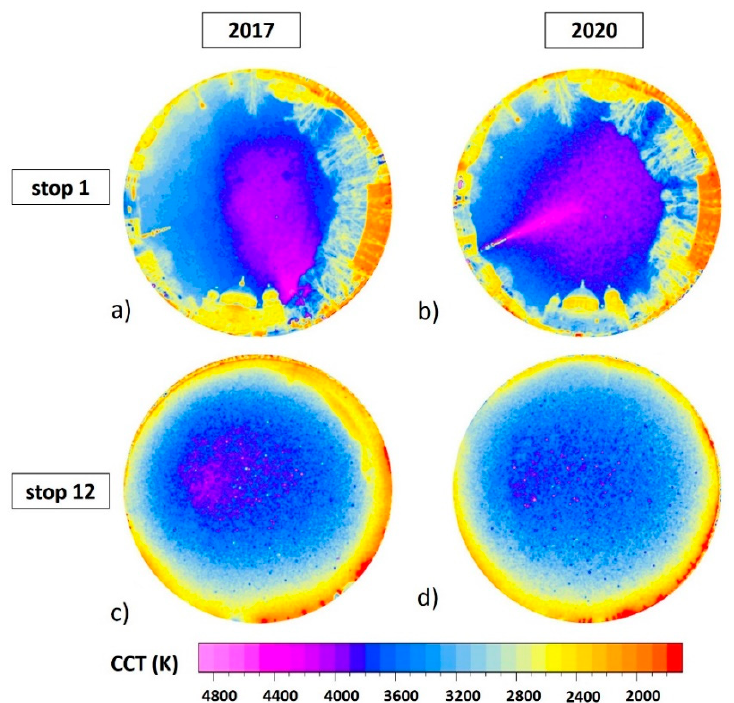
Figure 3. Correlated color temperature (CCT) maps for two of the twelve stops near Berlin, Germany. ( a , b ) stop 1 near city center, and ( c , d ) stop 12 farthest away from the city center. ( a , c ) 2017—no lockdown and ( b ), and ( d ) 2020—lockdown. The full imaging dataset is given in Appendix A.